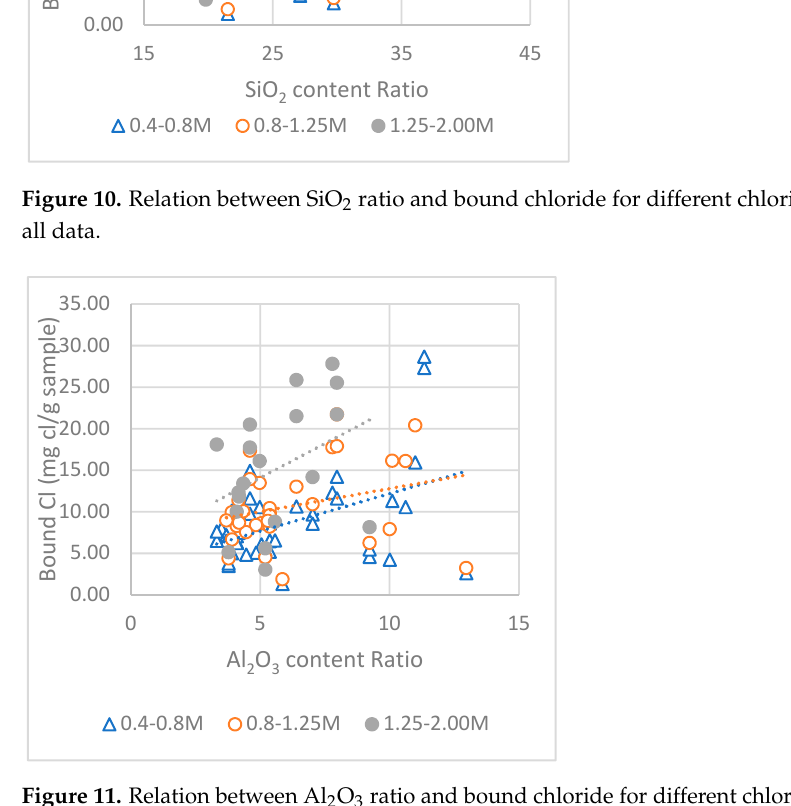
Figure 12. Relation between CaO/SiO 2 ratio and bound chloride for different chloride concentrations for all data. Figure 13. Relation between CaO/Al 2 O 3 ratio and bound chloride for different chloride concentra- tions for all data.